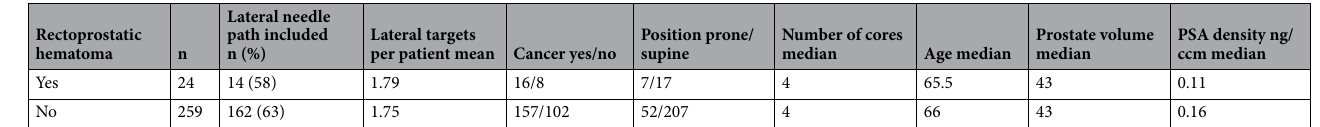
Table 3. Characteristics of the patients and the biopsy procedure for patients with and without localized rectoprostatic hematoma.